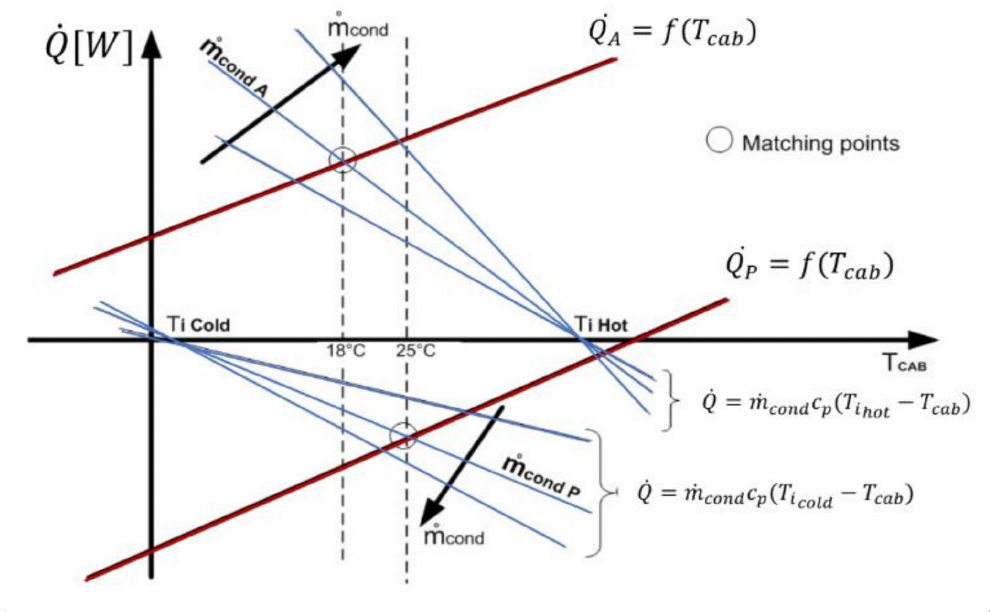
Figure 8. Cold and hot